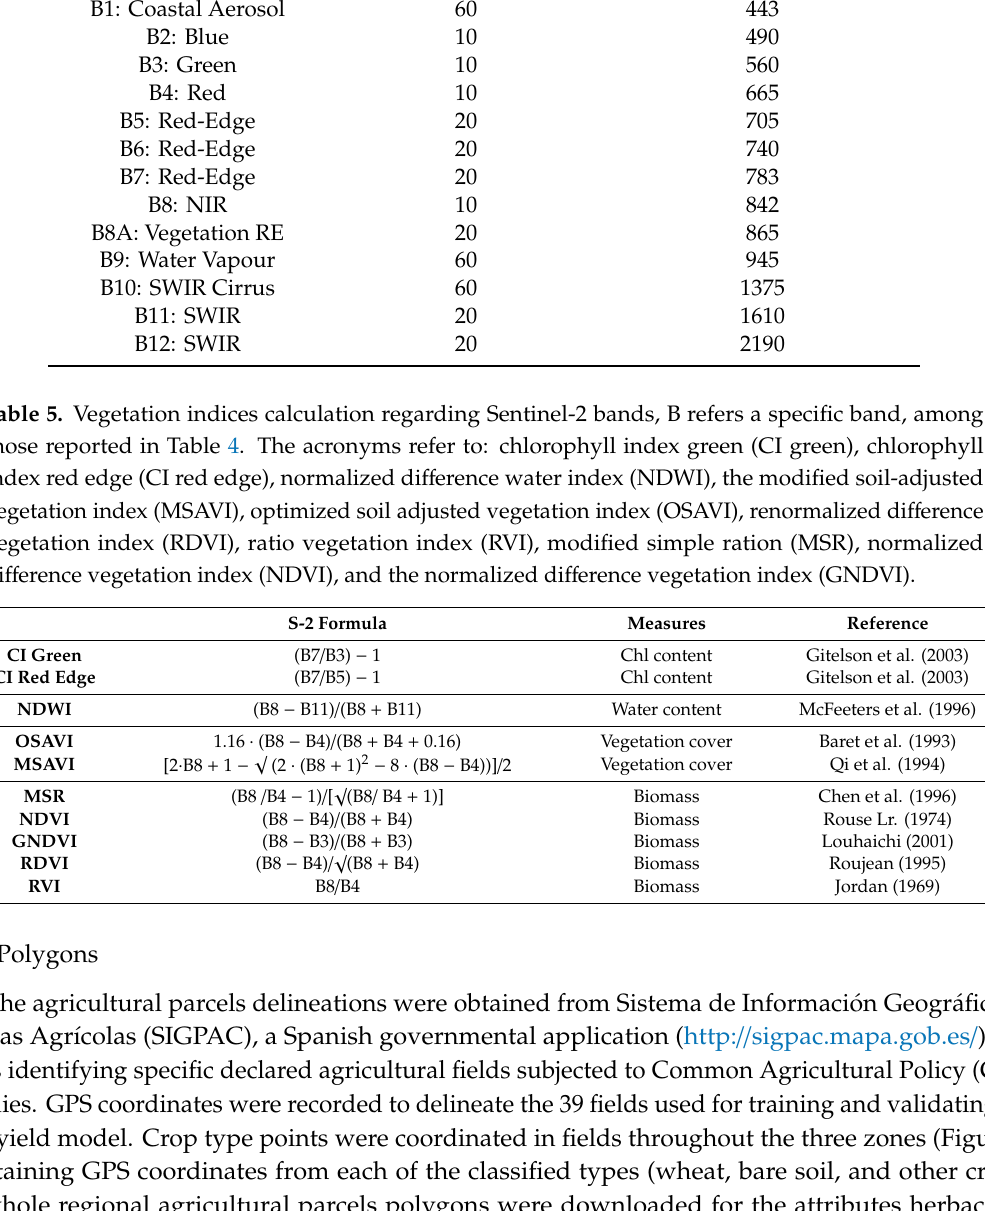
Table 4. Spectral bands and spatial resolutions of the Sentinel-2 Multispectral Instrument (MSI). Novelty in spectral coverage includes three red-edge spectral bands and the vegetation red-edge (RE) at 20 m as well as improved SWIR (Short-Wave InfraRed) coverage at 20 and 60 m spatial resolutions. Broadband spectral coverage of the visible and near infrared are provided at 10 m spatial resolution.